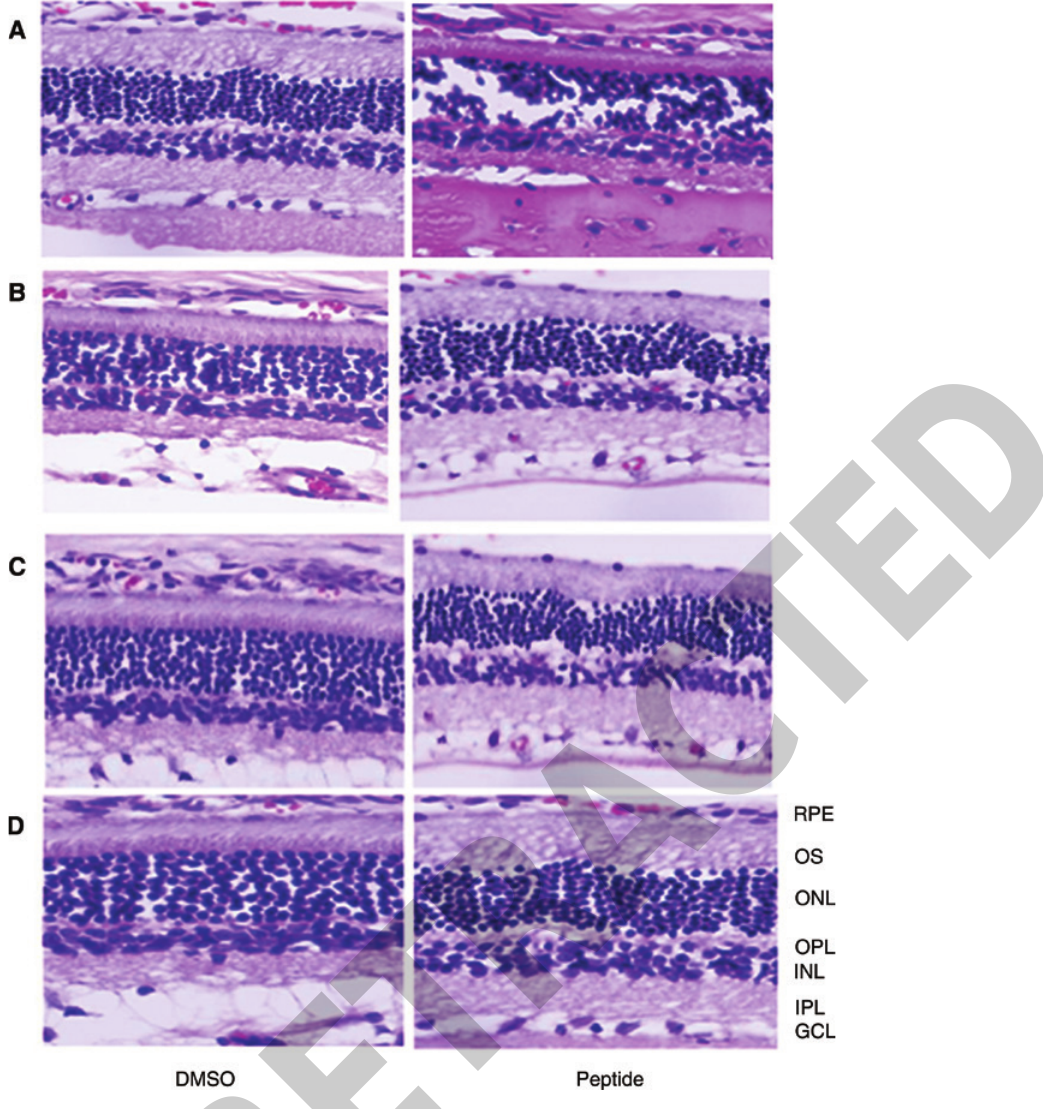
Figure 5: Morphology of the retina. Representative histology (hematoxylin and eosin stained) images of rat retina. Panel A: ADan-red; panel B: ADan-oxi; panel C: A β 1-40; and panel D: A β